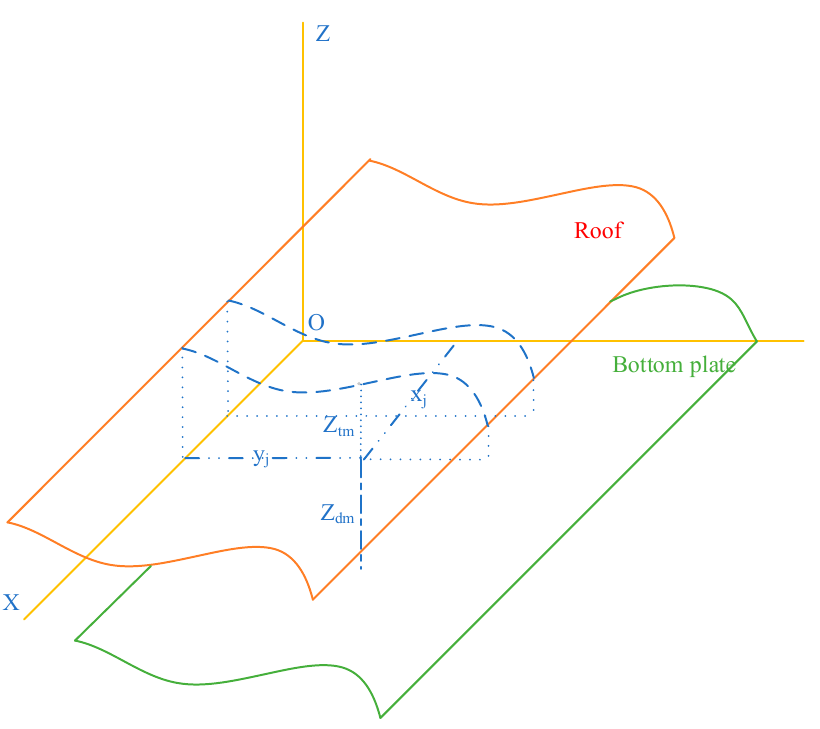
Figure 1. Schematic diagram of “CT” slicing technology.